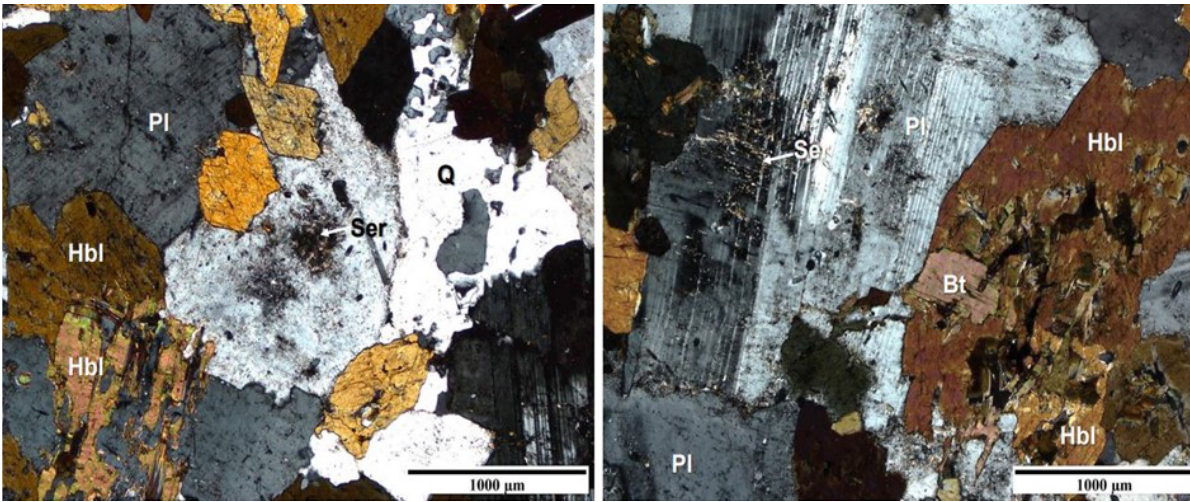
Fig. 4. Microphotograph of the first phase diorite, Taatsiin Gol pluton, Khangai Complex (Si-36) Hbl- hornblende, Pl-plagioclase, Q-quartz, Bt-biotite, Ser-sericite.